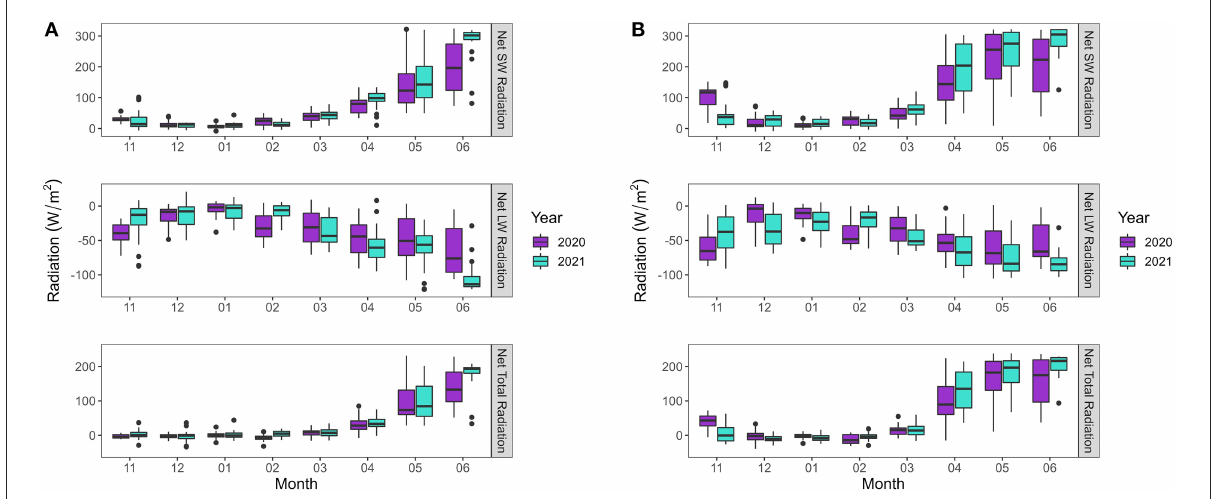
FIGURE5 Daily average net longwave (LW), net shortwave (SW) and net total radiation (NR, LW + SW) at the BT (A) and LDP (B) locations for each month and year. All measurements are from the weather station located in open canopy cover sites at each study location.